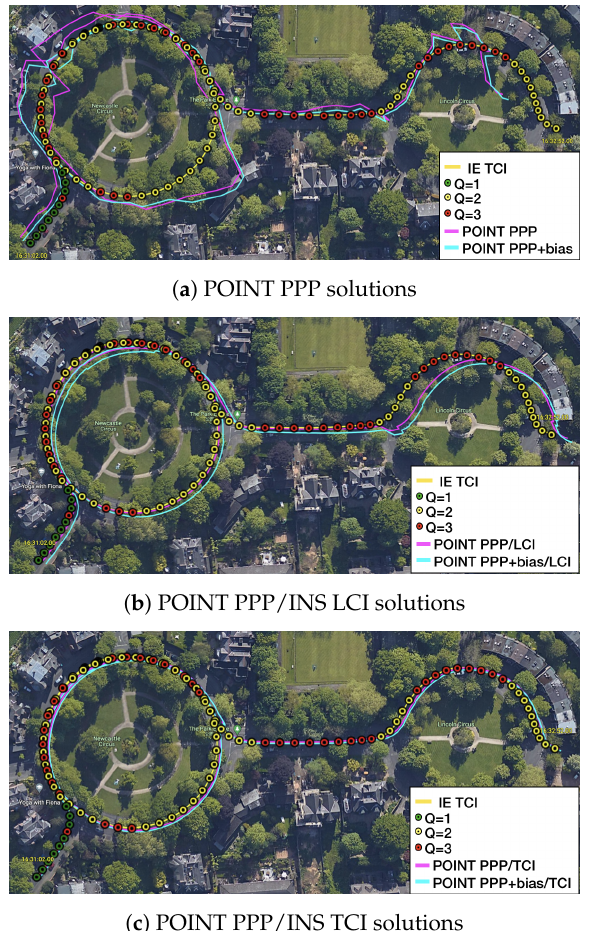
Figure 29. Example 1 of city center test on Google